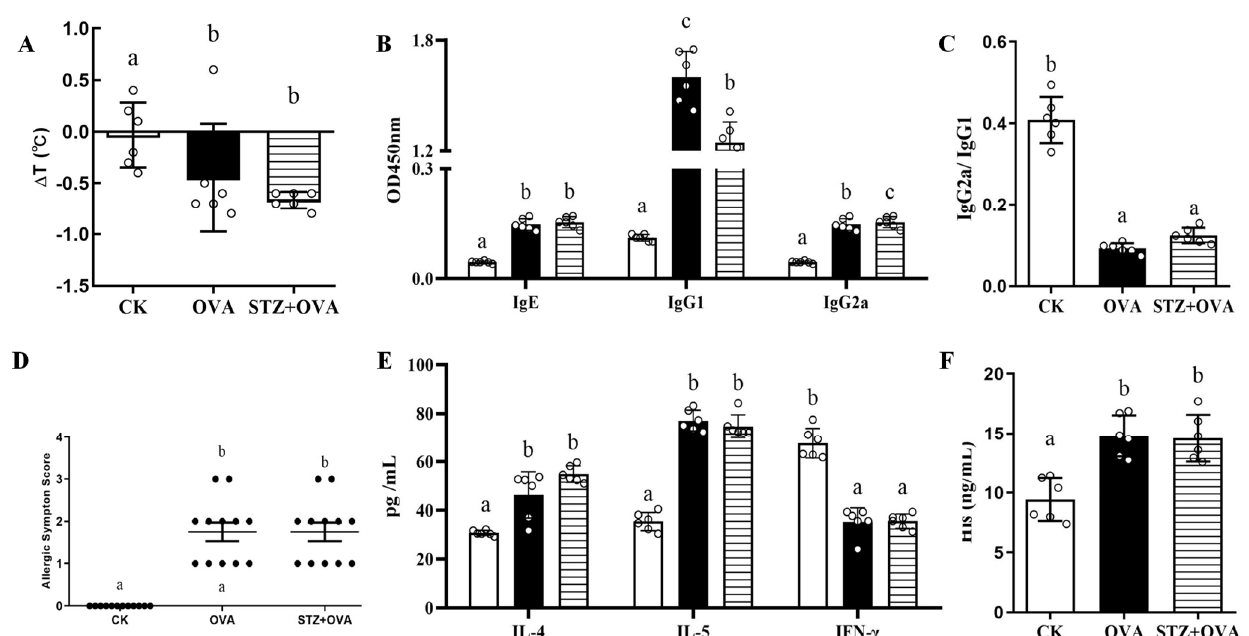
Figure 3. Effects of diabetes on food allergy. ( A ), Rectal temperature change. ( B ), Serum-specific antibody levels of IgE, IgG1, and IgG2a. ( C ), Serum-specific antibody IgG2a/IgG1 level. ( D ), Food allergy symptom score. ( E ), Cytokines levels of IL-4, IL-5, and IFN-γ. ( F ), Histamine levels. The error bars indicated the mean ± SEM. n = 6. Different lowercase letters in the figure represent significant differences between the groups ( p < 0.05 by one-way ANOVA followed by SNK).